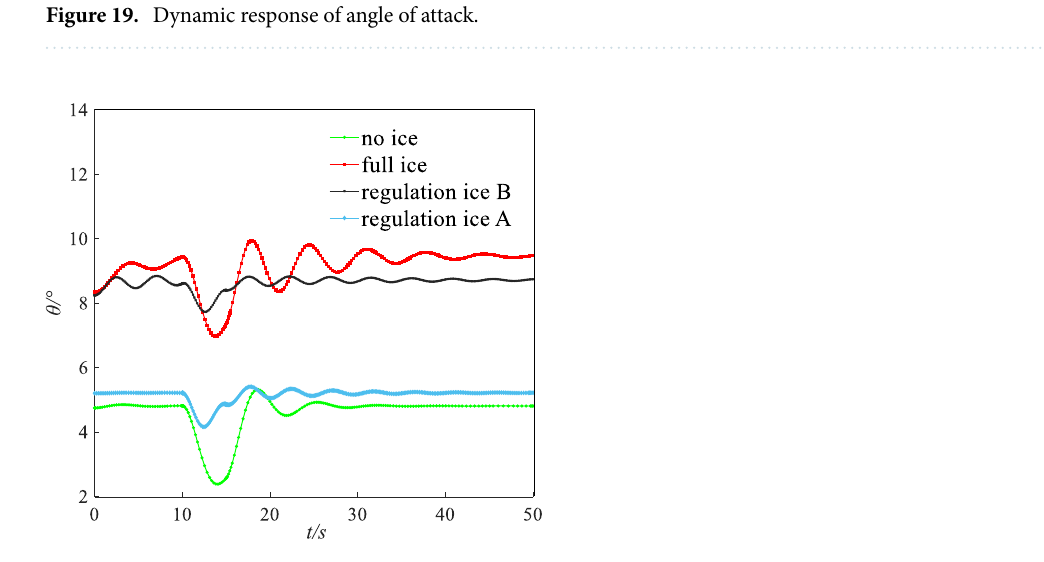
Figure 20. Dynamic response of pitching